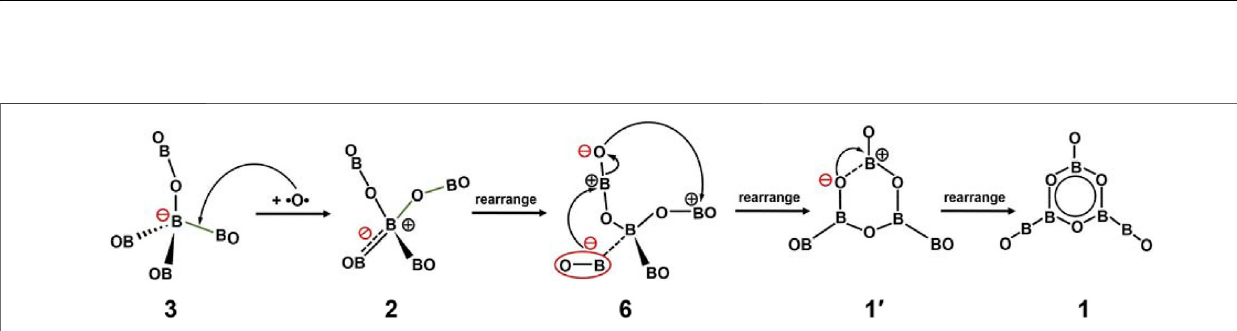
FIGURE 10 | Plausible mechanism for the structural evolution between tetrahedral B 5 O 5 − (3) and hexagonal B 5 O 6 − (1) clusters.